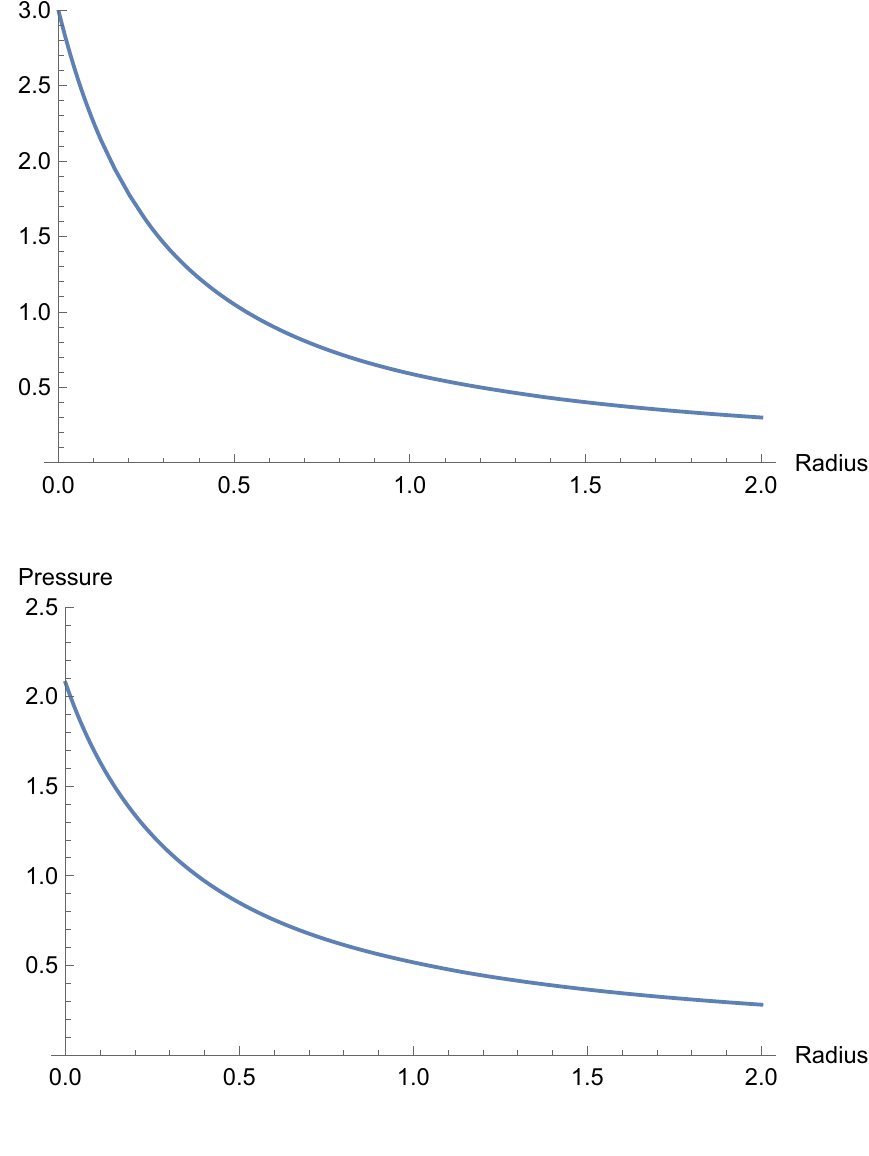
Fig. 11 Density ρ versus the radial variable x